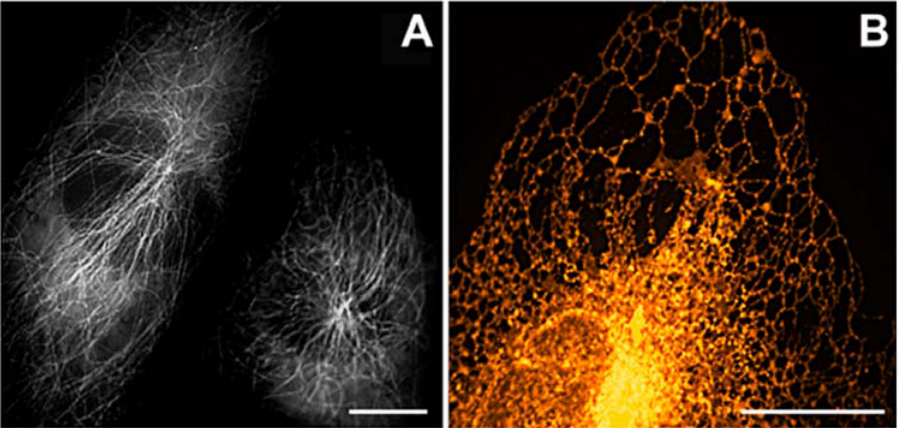
Figure 3. Applications of mRuby as a cellular marker protein. (A) Epifluorescence image of NIH3T3 cells expressing mRuby fused to human a - tubulin. Two cells from a single image were arranged in closer proximity (B) Spinning-disk confocal image of the endoplasmic reticulum of a HeLa cell stained with ER-mRuby-KDEL. False colors encode fluorescence intensity. Bars: 2.5 m m.